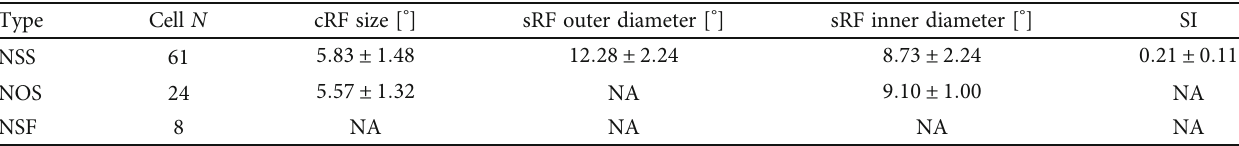
NA represents values that are not